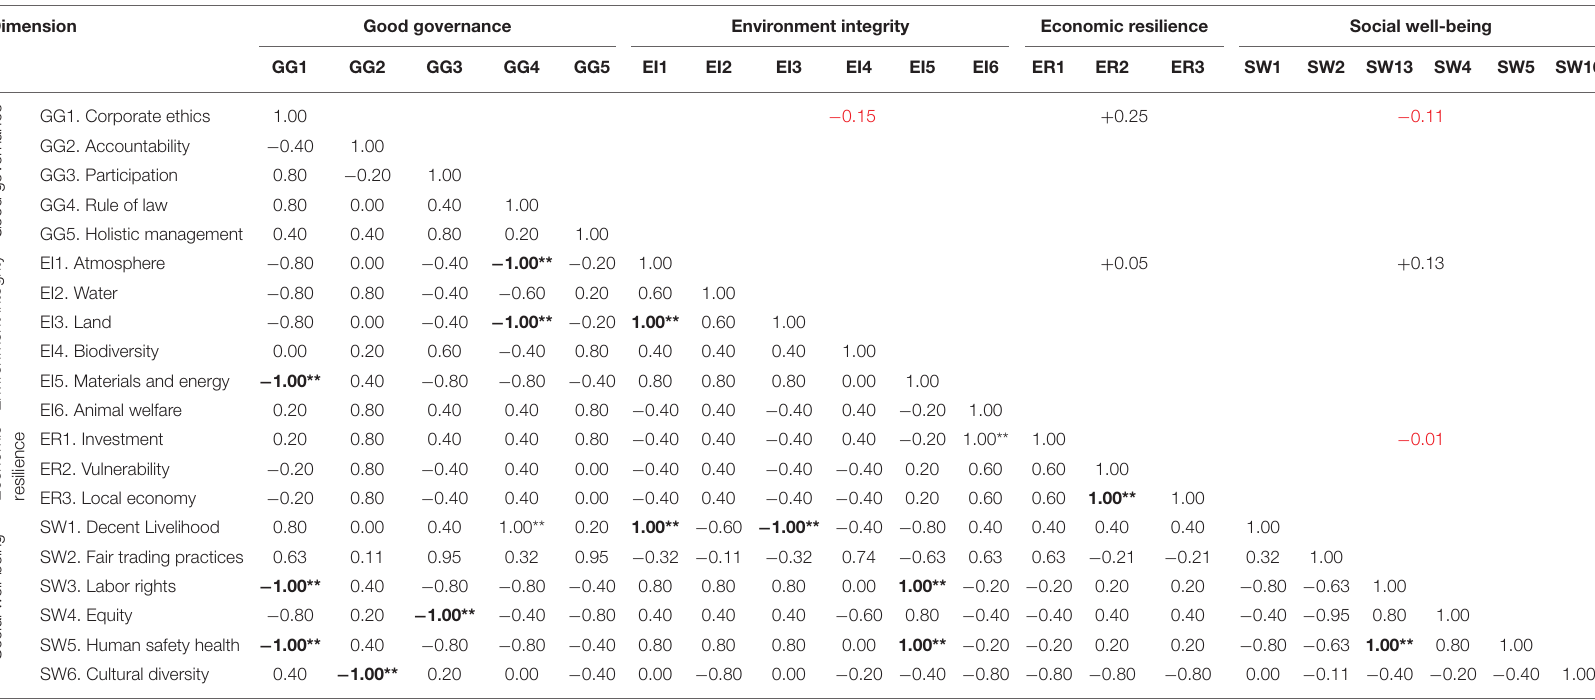
** Correlation is significant at 0.01 level. Trade-offs: results in red; and Synergies: results in